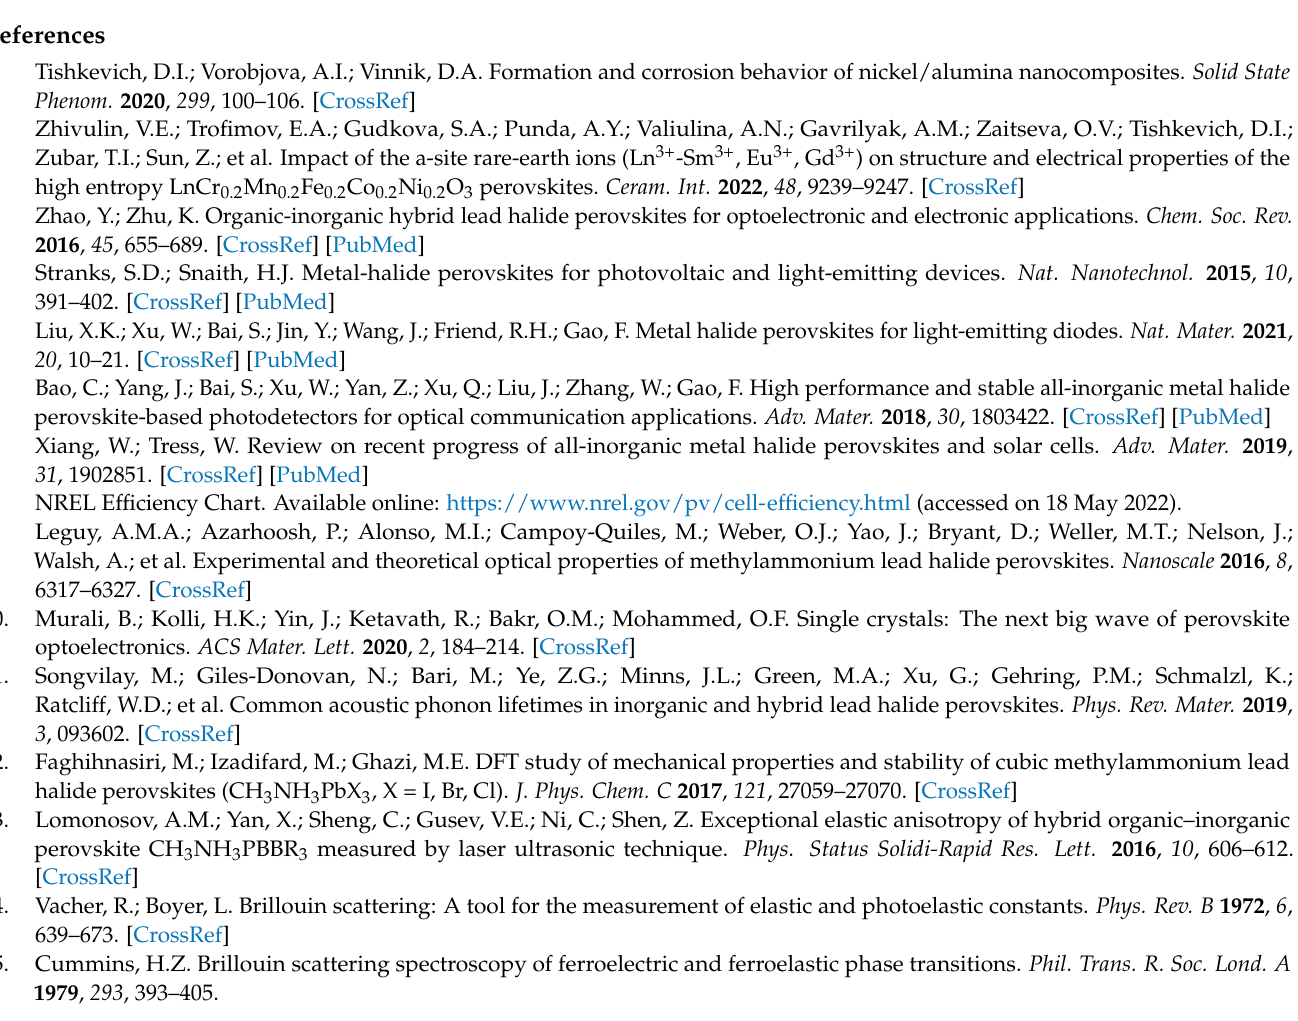
Figure S2: Temperature dependences of (a) the mode frequency and (b) the FWHM of the TA mode propagating along the [100] direction measured upon cooling and heating; Figure S3: Temperature dependences of (a) the mode frequency and (b) the FWHM of the TA mode propagating along the [100] direction measured upon cooling and